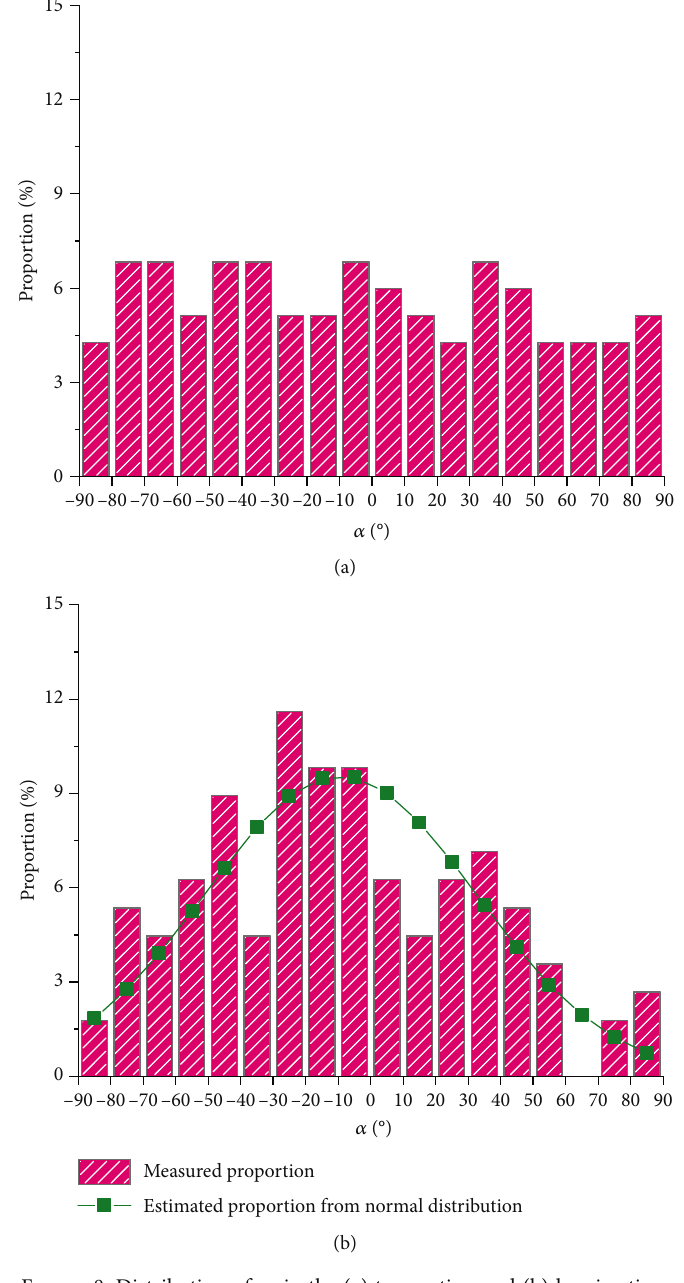
Figure 8: Distribution of α in the (a) transection and (b)